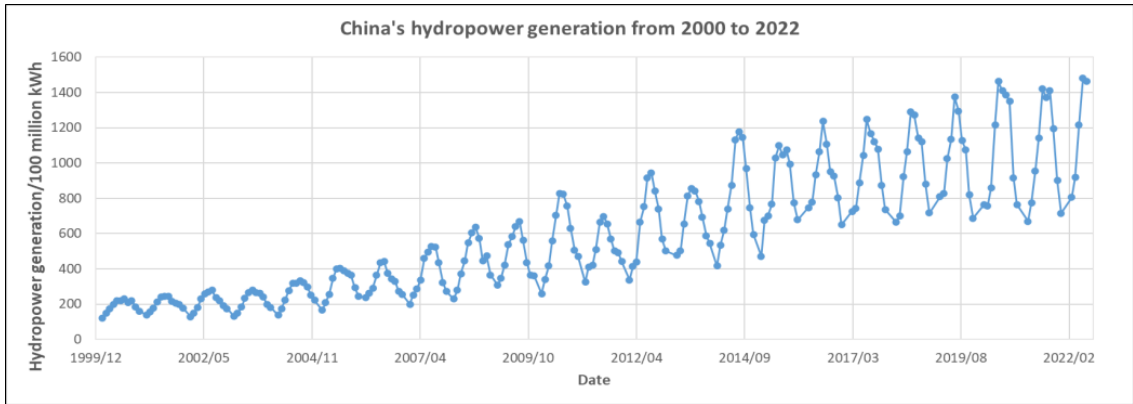
Figure 4. China’s hydropower generation data from 2000 to 2022.